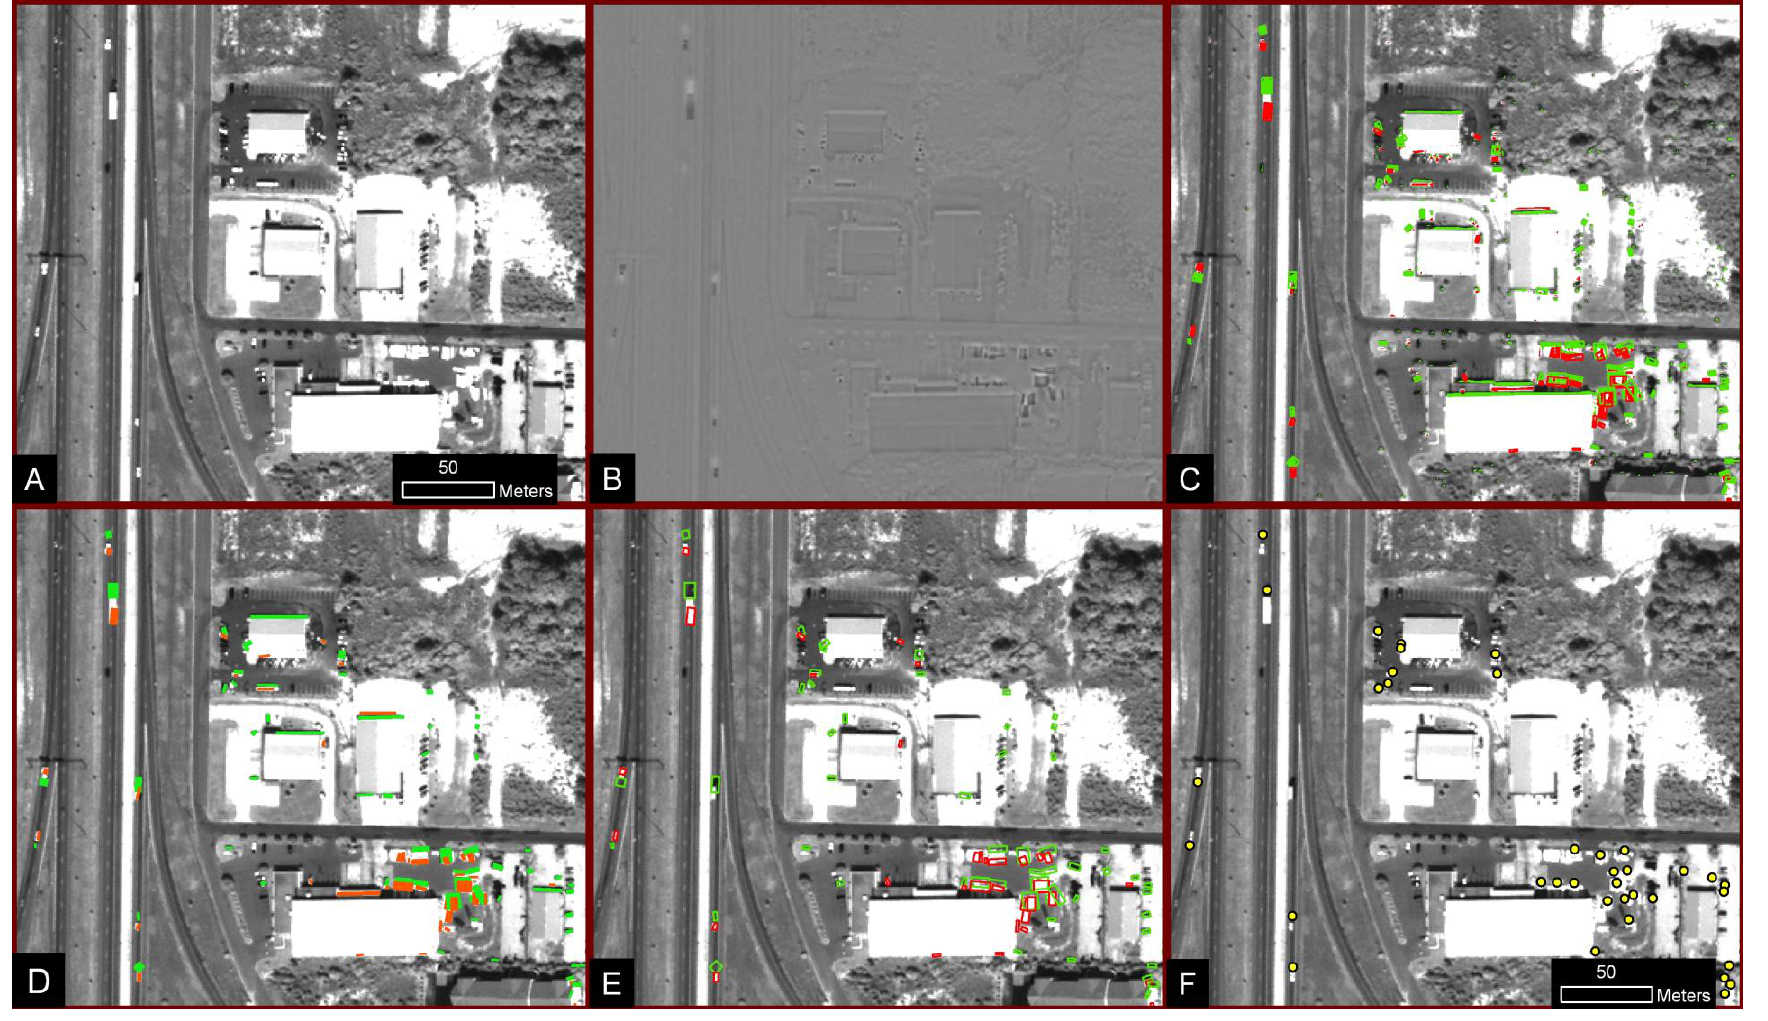
Figure 3. Panchromatic subset of 60 km 2 scene 1 (a) . Difference method applied (b) . Raster to vector conversion (c) ; 512 local polygons, 284,544 global polygons; sieving the polygons by area (d) ; 107 local and 34,807 global polygons remain, polygons over 4:1 elongation ratio removed (e) ; 92 local and 18, 945 polygons remain, and Paired centroids; 38 local and 6,725 global pairs (f)